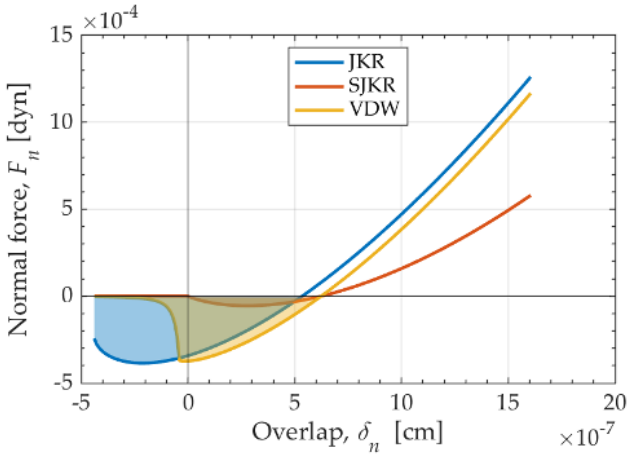
Figure 7. Illustration of the cohesion energy with the three cohesion models VDW, JKR,